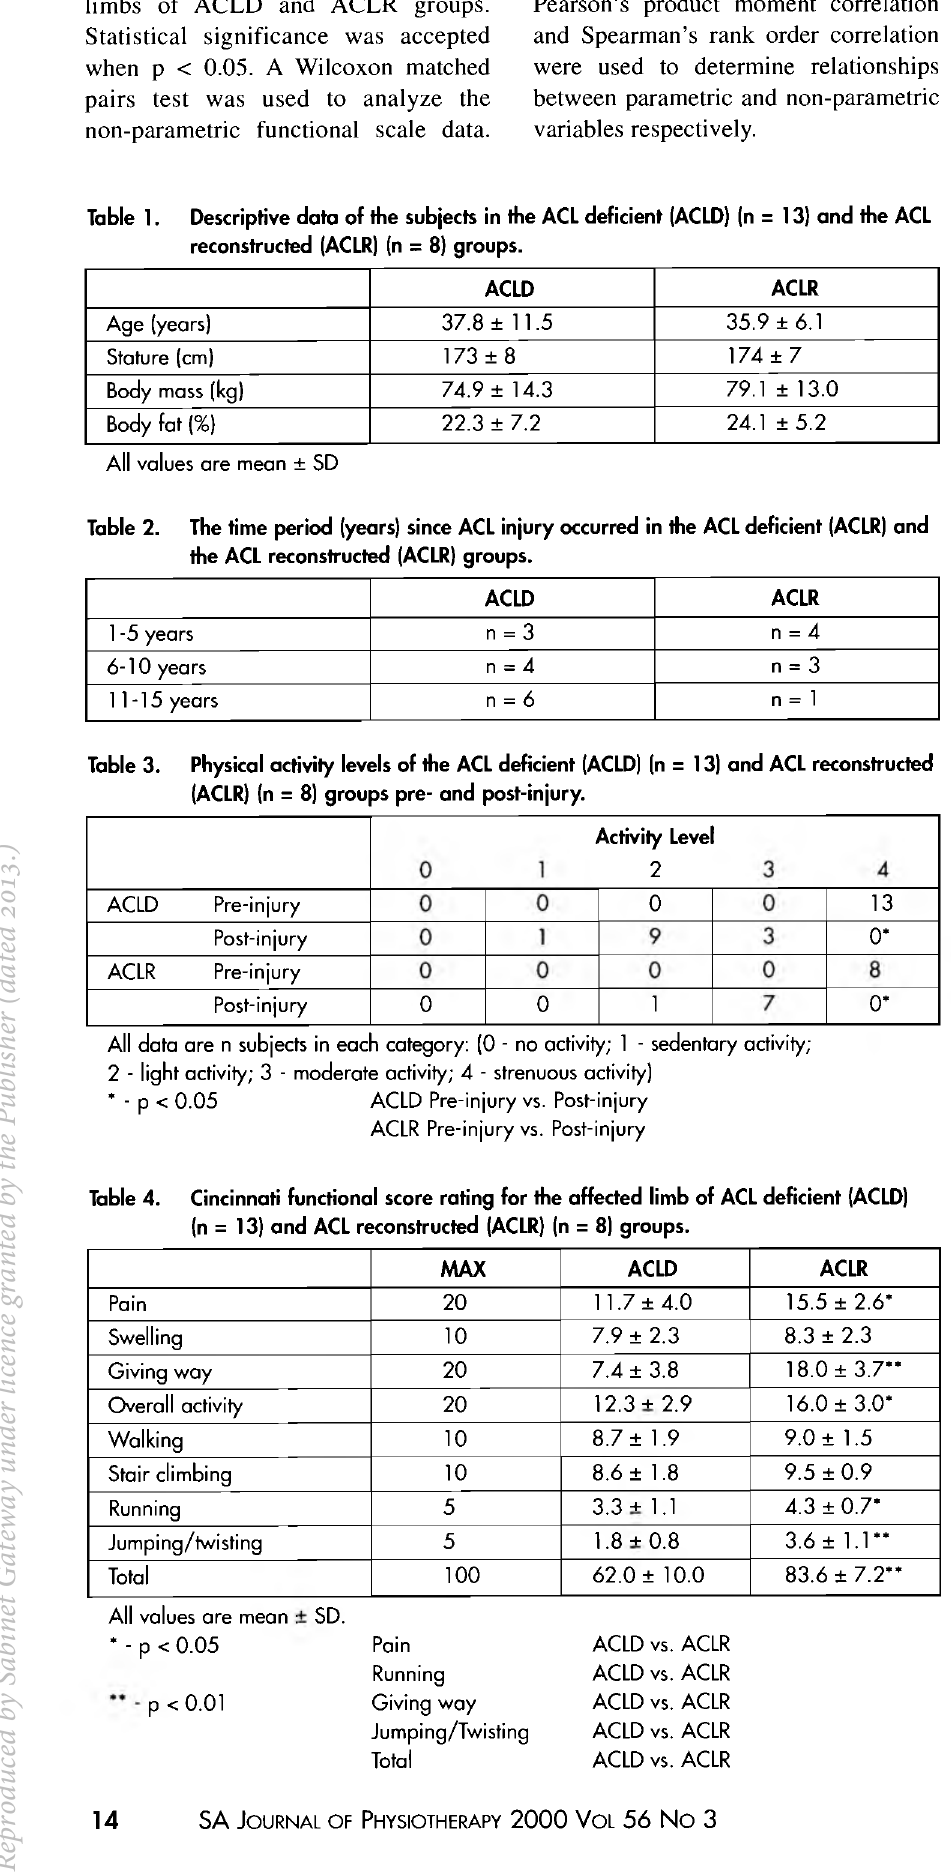
pairs test was used to analyze the non-parametric functional scale data.